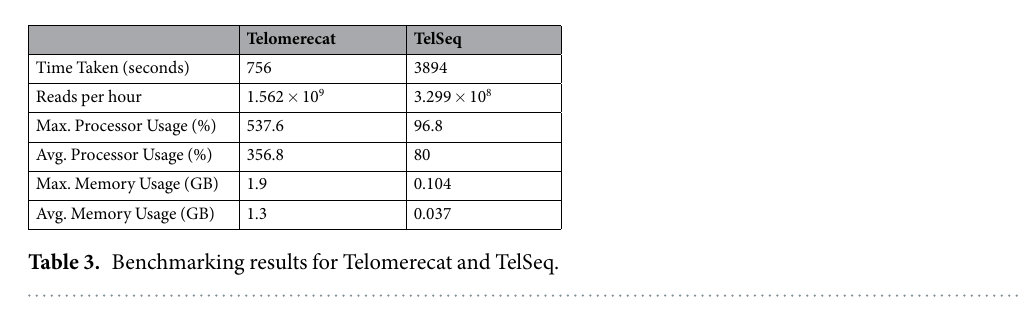
Mouse telomeres are known to be longer than human telomeres 33 .